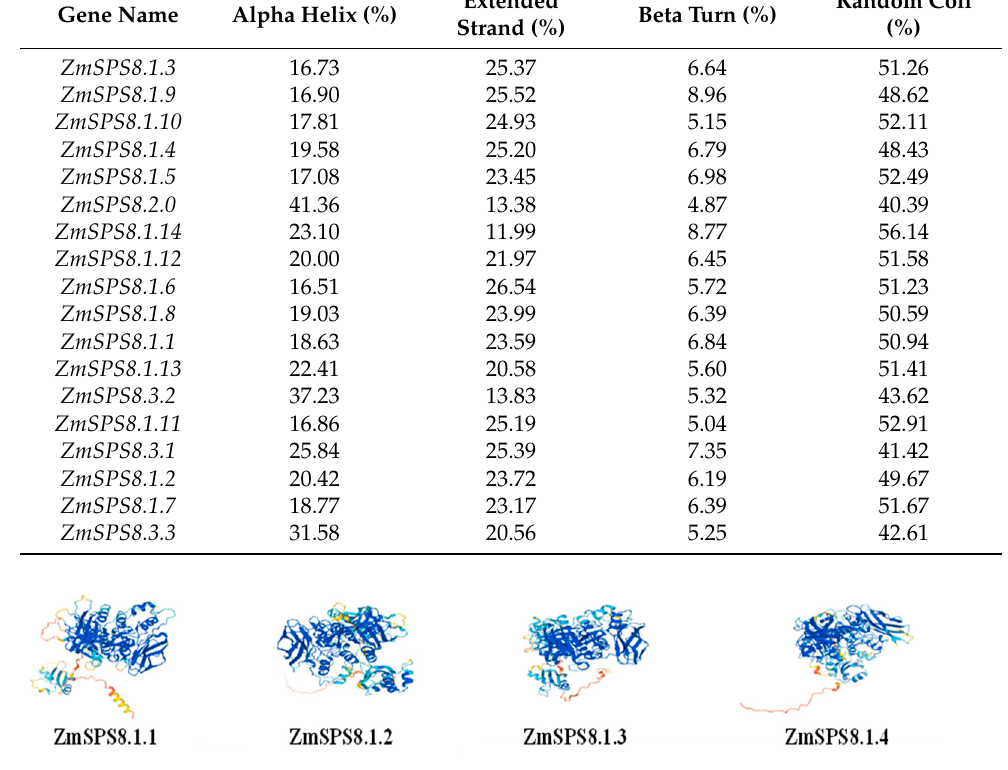
Table 3. Secondary structural statistics of the serine peptidase S8 family proteins.